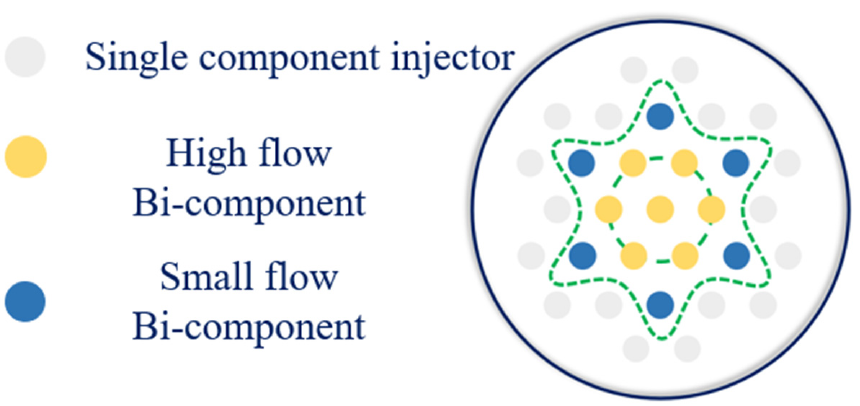
Figure 3. Injector distribution in the injection panel.